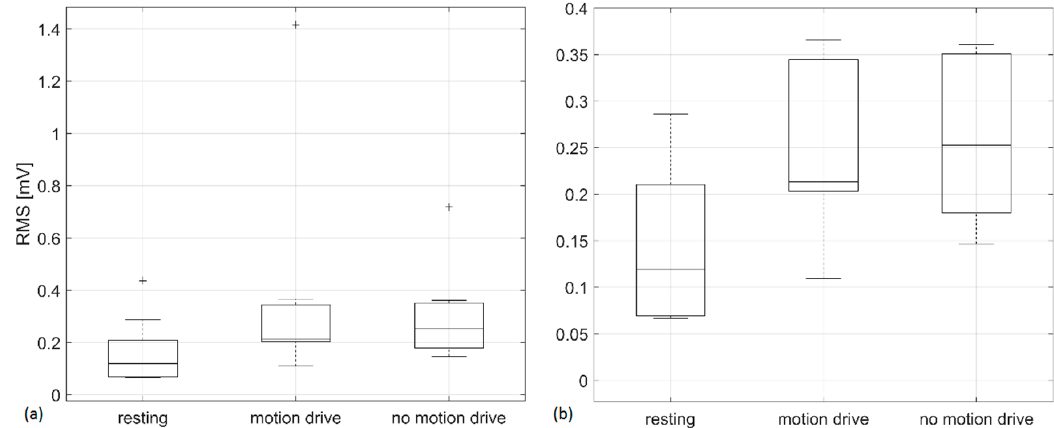
Figure 8. Box plots presented for RMS values divided into three groups: resting, motion, and no motion ( a ). A zoomed box plot is presented on ( b ) (from 0 to 0.4 mV). Table 3. Simulator Sickness Questionnaire (SSQ) results for 13 subjects. ID1-ID9 are subjects included in the EGG analysis. IDN1-IDN4 are subjects excluded from the study (see the main text for more details). Shaded subjects experienced higher SS symptoms, as revealed by the